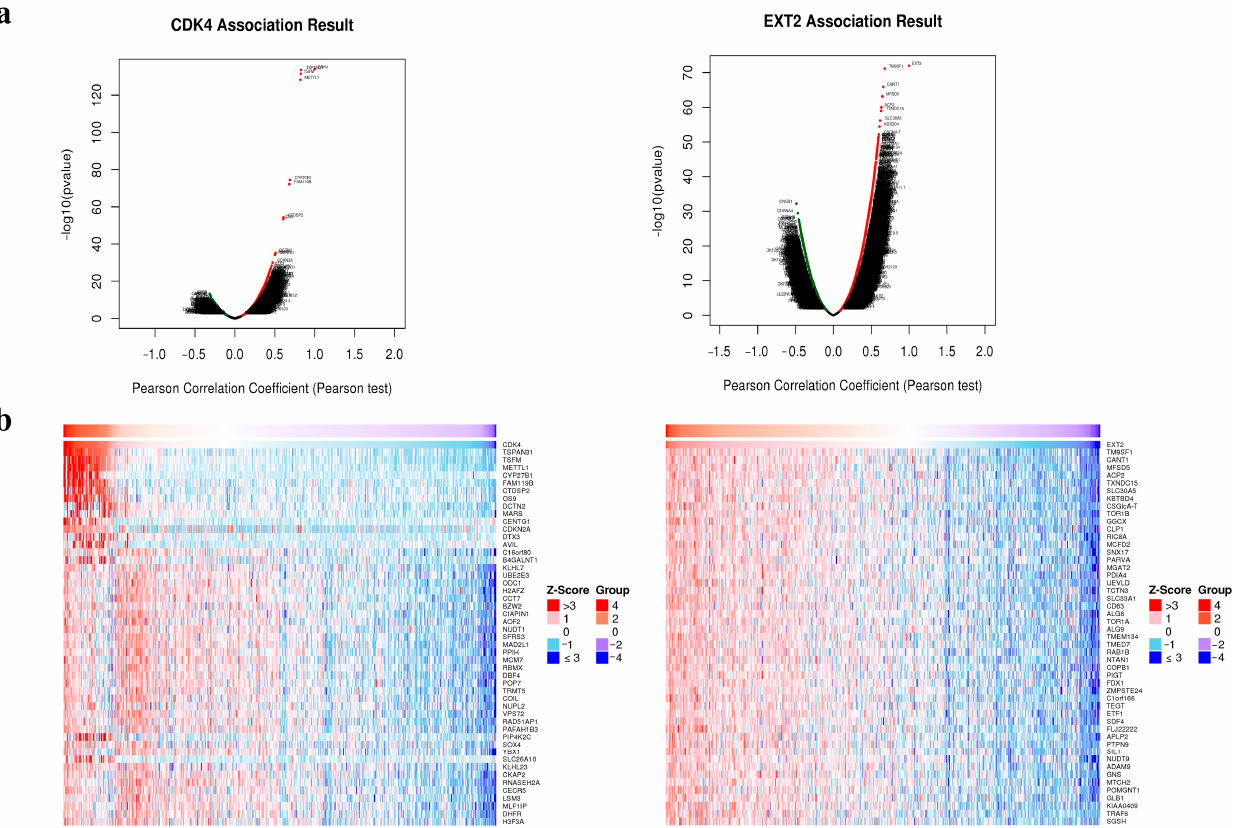
Figure 6. Co-expression networks of CDK4 and EXT2 . ( a ) Volcano plots show highly correlated genes of CDK4 (left) and EXT2 (right) tested by Pearson test in the glioblastoma (GBM) cohort by the LinkedOmics database. Dark red dots indicate genes positively correlated; dark green dots indicate genes negatively correlated. ( b ) Top 50 positive co-expressed genes of CDK4 (left) and EXT2 (right) in heat maps in the GBM cohort by the LinkedOmics database.